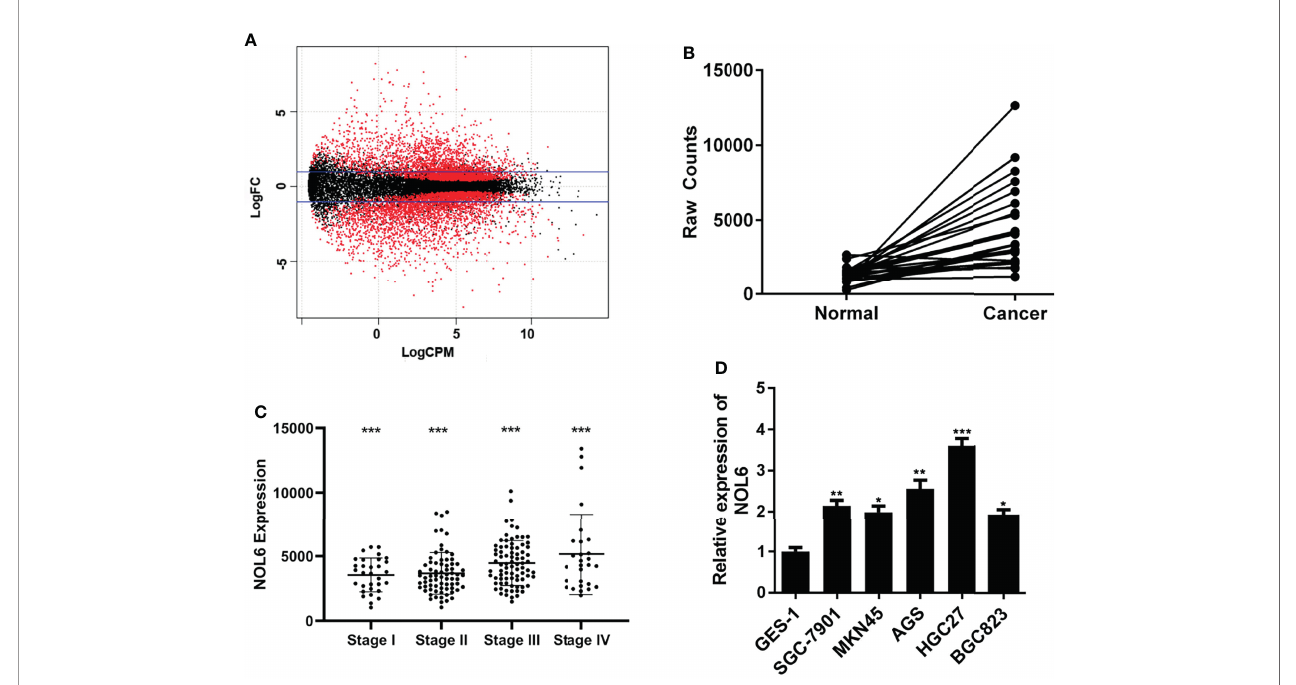
FIGURE 1 | NOL6 gene was highly expressed in gastric cancer cells. (A) Differentially expressed genes generated by DEGseq package in ‘ R ’ . The red points indicated the statistically signi fi cant differentially expressed genes in gastric cancer; logFC: log-fold-changes between each pair of RNA samples; logCPM: log2 counts-per-million. (B) NOL6 expression was observed obviously higher in gastric cancer tissues than that in adjacent normal tissues. (C) The NOL6 expression in the tissues from different clinical pathological stage was evaluated by qRT-PCR. (D) The gene expression of NOL6 in six cell lines (GES-1, SGC-7901, MKN45, HGC-27, BGC-823 and AGS) 7(*p < 0.05, **p < 0.01, ***p <